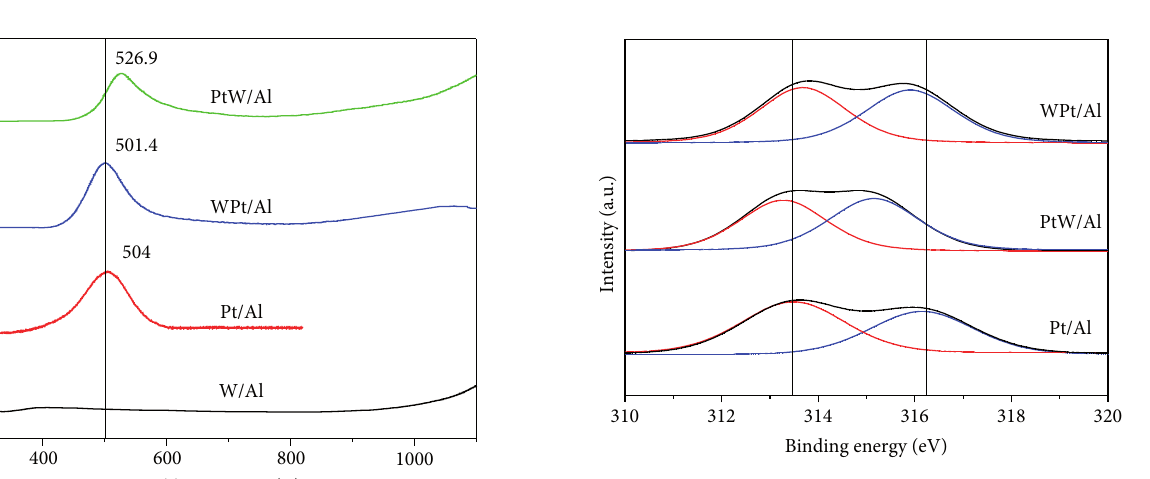
F 2: XPS spectra of the Pt 4d